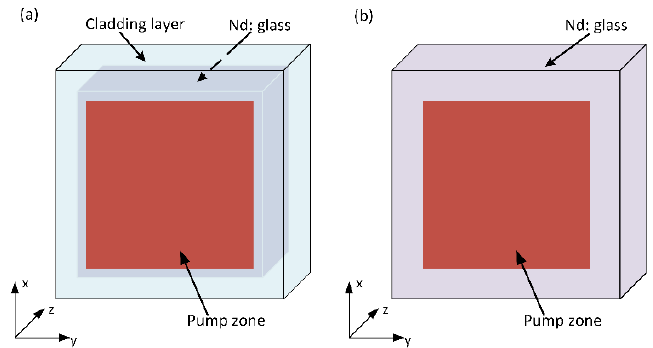
Figure 3. Structure of the gain slab ( a ) with the absorbing cladding layer and ( b ) without the absorbing cladding layer.